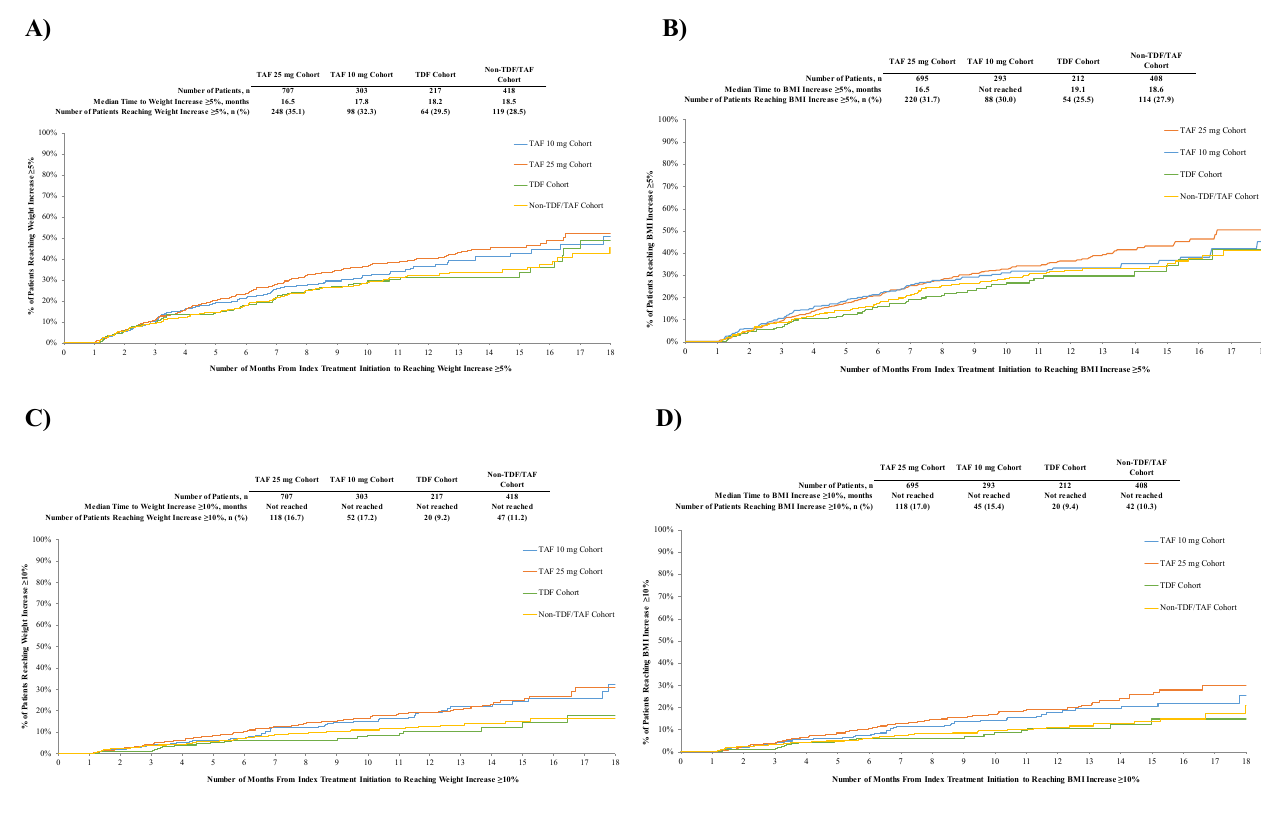
Figure 4. Kaplan-Meier Curves of Time to Weight Gain or BMI Increase ≥5% or ≥10%